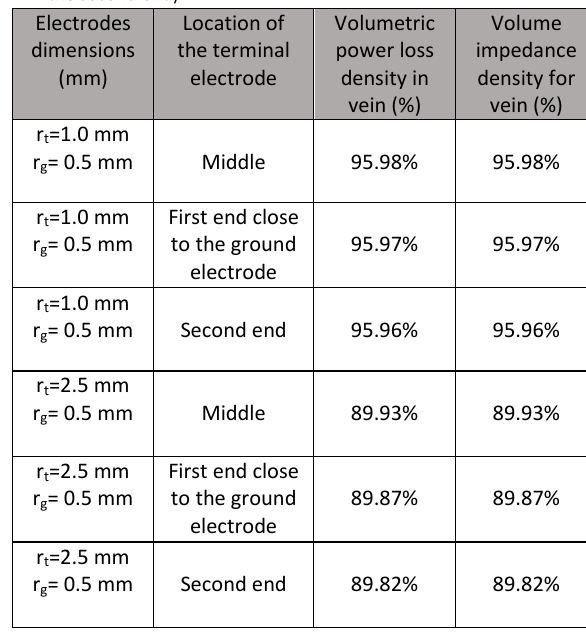
Table 3: Simulations results including the percentage of the volumetric power loss density and volume integration of volume impedance density for vein and with two different surface and ground electrode dimensions (r t = 1 mm and r g = 0.5 mm versus r t = 2.5 mm and r g = 0.5 mm), regardless of the number of surface electrodes (28, 32, 44 and 48) and with only one surface electrode excited as the terminal (middle electrode, electrode at the first end close to the ground electrode output or electrode